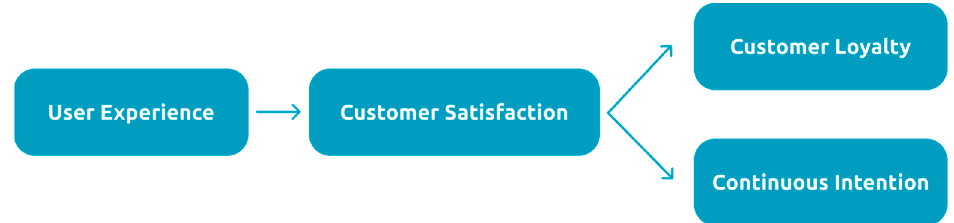
Figure 1. The relationship among user experience, customer loyalty, and continuous intention.